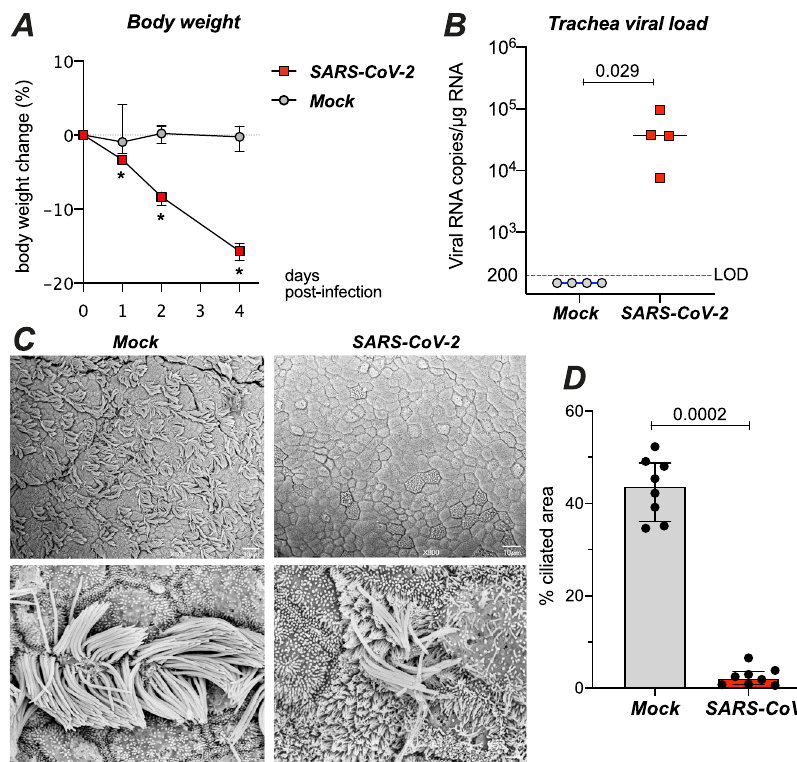
Fig. 7 SARS-CoV-2 damages the ciliary layer in the respiratory tract of Syrian golden hamsters. A Effect of intranasal SARS-CoV-2 infection on hamster body weight ( n = 4 per group; median ± IQR). Differences between groups were measured by a Mann – Whitney test (* P < 0.05). B SARS-CoV-2 viral load measured at 4 dpi in hamster trachea by RT-qPCR ( n = 4 per group; medians, Mann – Whitney test). LOD limit of detection. C SEM images of tracheal epithelia from mock (left panels) and SARS-CoV-2-infected (right panels) hamsters at 4 dpi. Enlarged views of ciliated cell are shown in bottom panels. D Quanti fi cation of ciliated area in hamster tracheas imaged by SEM (SARS2: n = 3, MOCK: n = 2; 2 – 4 images per sample). Differences between medians ± IQR were measured by a Mann – Whitney